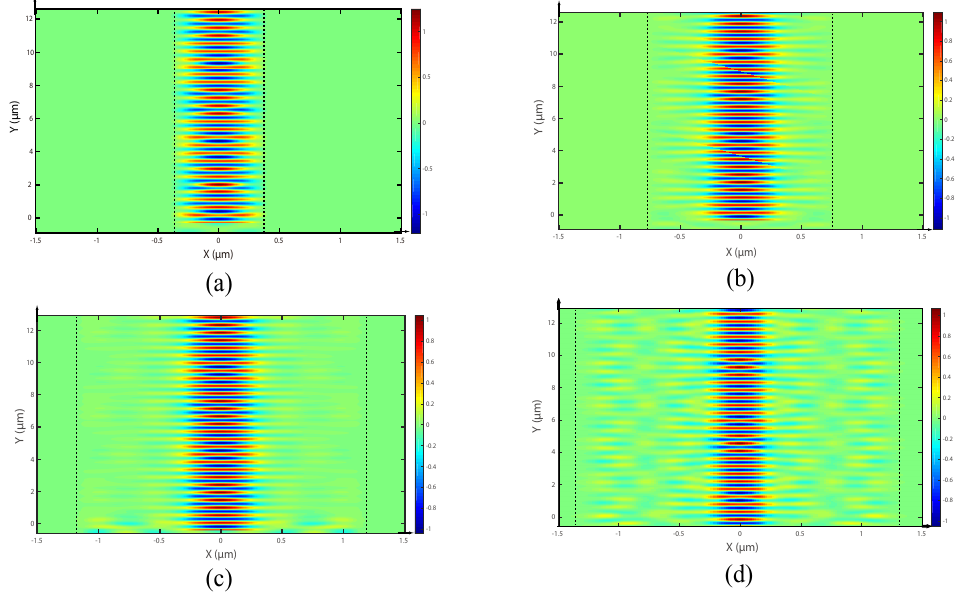
Figure 3. The E z fields of waveguides with different column numbers of air holes (( a – d ) 0.5, 1.5, 2.5, 3.5 columns, respectively) at the wavelength of 1.55 µ m. The dotted lines represent the boundaries between metal and silicon.